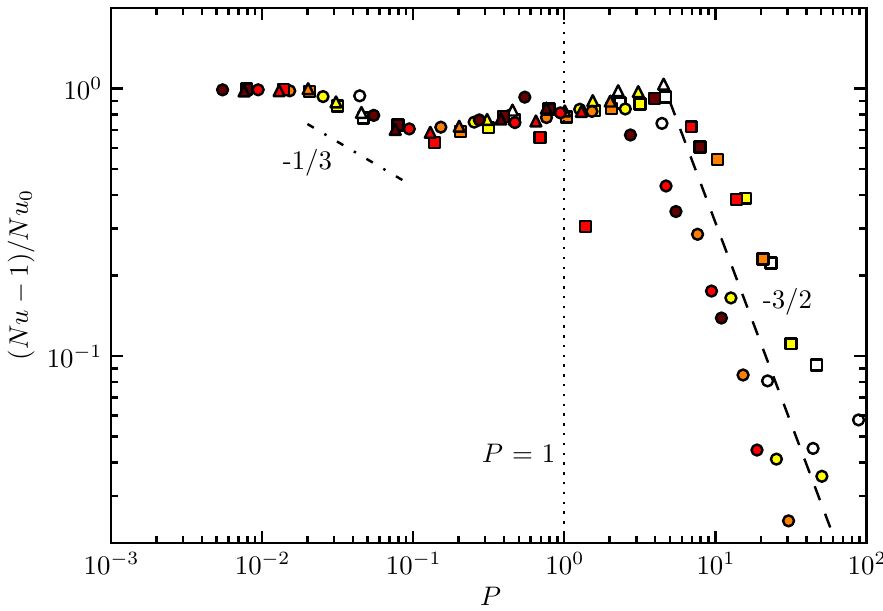
Figure 7. The reduced Nusselt number ( Nu 1 ) Nu − 1 plotted against P . The dashed line has a slope 0 − of 3/2 which can be compared with the slope of the datapoints. The Nusselt number is expected to − decrease at this rate for high P . The dashed-dotted line has a gradient of 1/3, this rate of decrease in − the Nusselt number may be expected if Stewartson layers were throttling the flow. The vertical dotted line marks the point where the Ekman layer and thermal boundary layer have approximately equal thickness at P = 1. The symbols are the same as in Figure